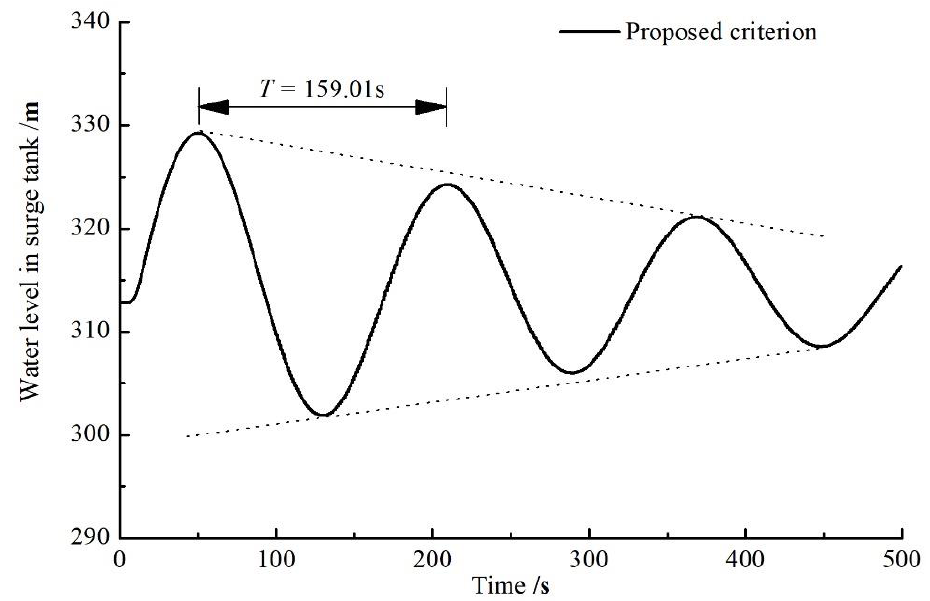
Figure 6. WLO process of the ST in case 1 under 100% load rejection.